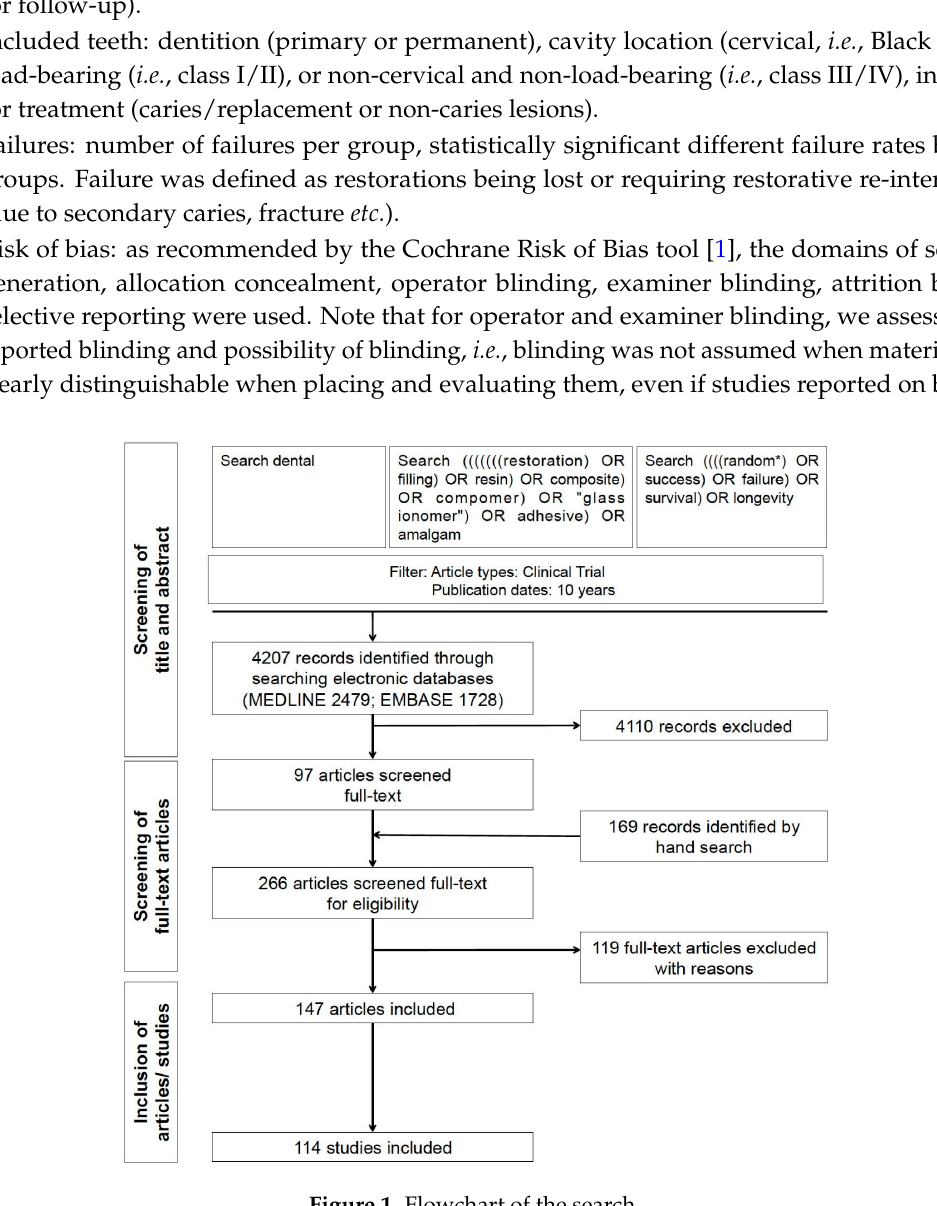
Figure 1. Flowchart of the search.